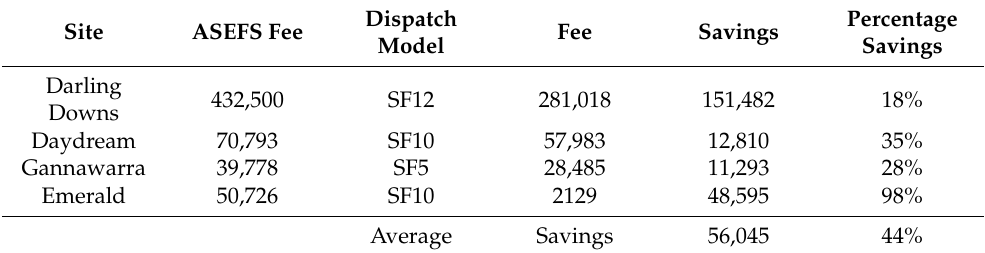
Table 4. Financial performance compared to ASEFS, Australian